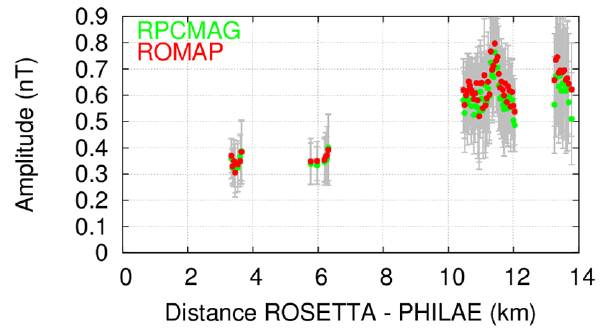
Figure 9. Amplitudes of magnetic fields observed by RPCMAG (green) and ROMAP (red) at the most significant frequencies plot- ted versus the orbiter-lander distance. The amplitudes represent the mean of all three components.